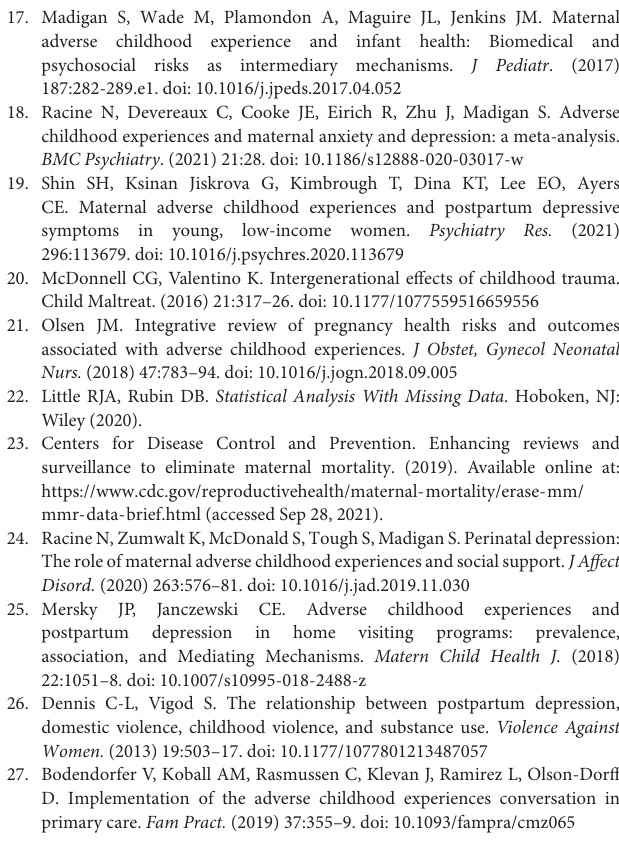
Supplementary Table 1 | Adverse Childhood Experience Survey. Questionnaire obtained from